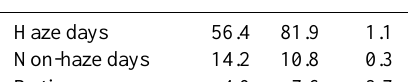
Table 4. Primary aerosol, SIA and SOA (µgm − 3 ) during haze days and non-haze days in Beijing.